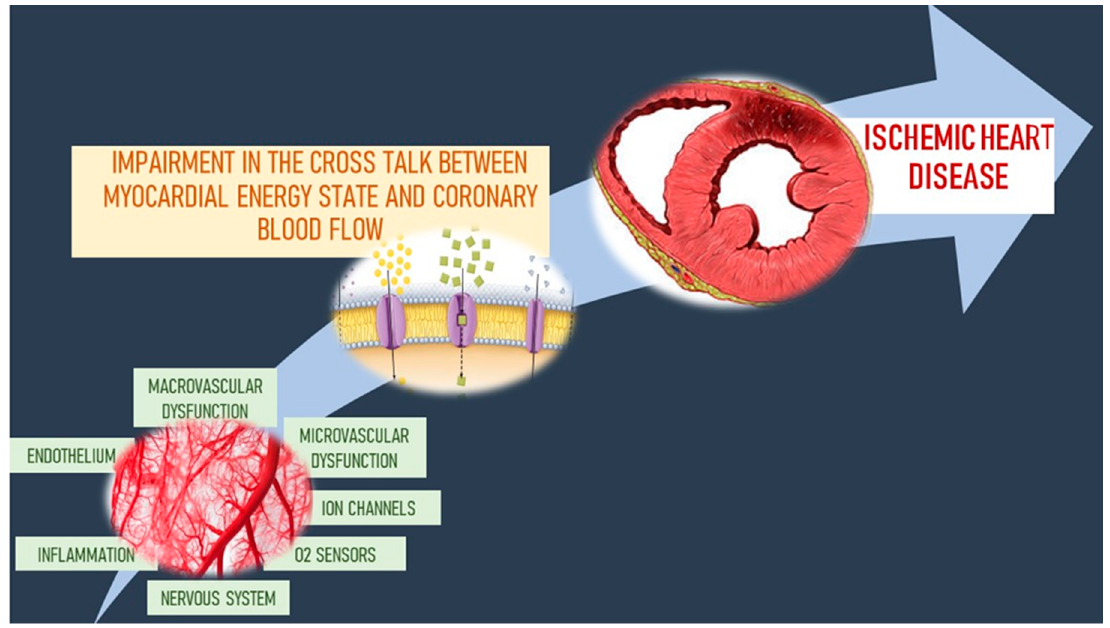
Figure 2. Mechanisms involved in ischemic heart disease pathophysiology and coronary ion channels role. Ischemic heart disease hides a multifaceted and complex pathophysiological paradigm. Several pathways are involved in the ischemic heart disease pathophysiology (i.e., micro and macrovascular dysfunction, atherosclerotic plaque rupture, inflammation, endothelium dependent and independent dysfunction, ion channels and nervous system impairment). In particular, coronary ion channels, represented in the central part of the figure, are the final effectors of coronary blood flow regulation mechanisms, playing a pivotal role in the coupling between myocardial metabolism and coronary circulation. Their activity dysregulation may occur during coronary microvascular dysfunction and other pathological conditions. It causes the impairment in the cross talk between myocardial energy state and coronary blood flow, leading to ischemic heart